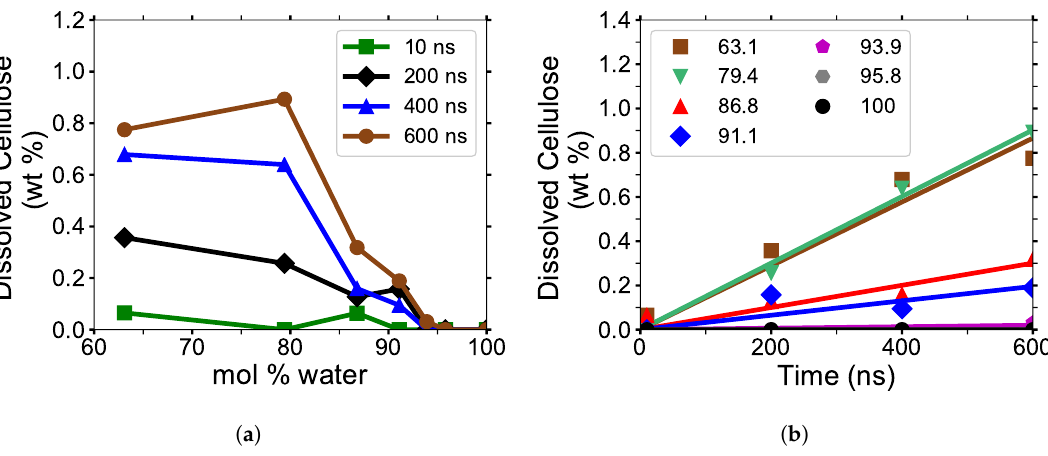
Figure 8. The simulated cellulose dissolution concentrations for the TBPCl–water solution at 360K: ( a ) cellulose dissolution vs. water concentration; ( b ) cellulose dissolution vs. time (dissolution rates). The legend in plot b indicates the water concentration in mol % water for the TBPCl–water solutions, while the slopes convey the cellulose dissolution